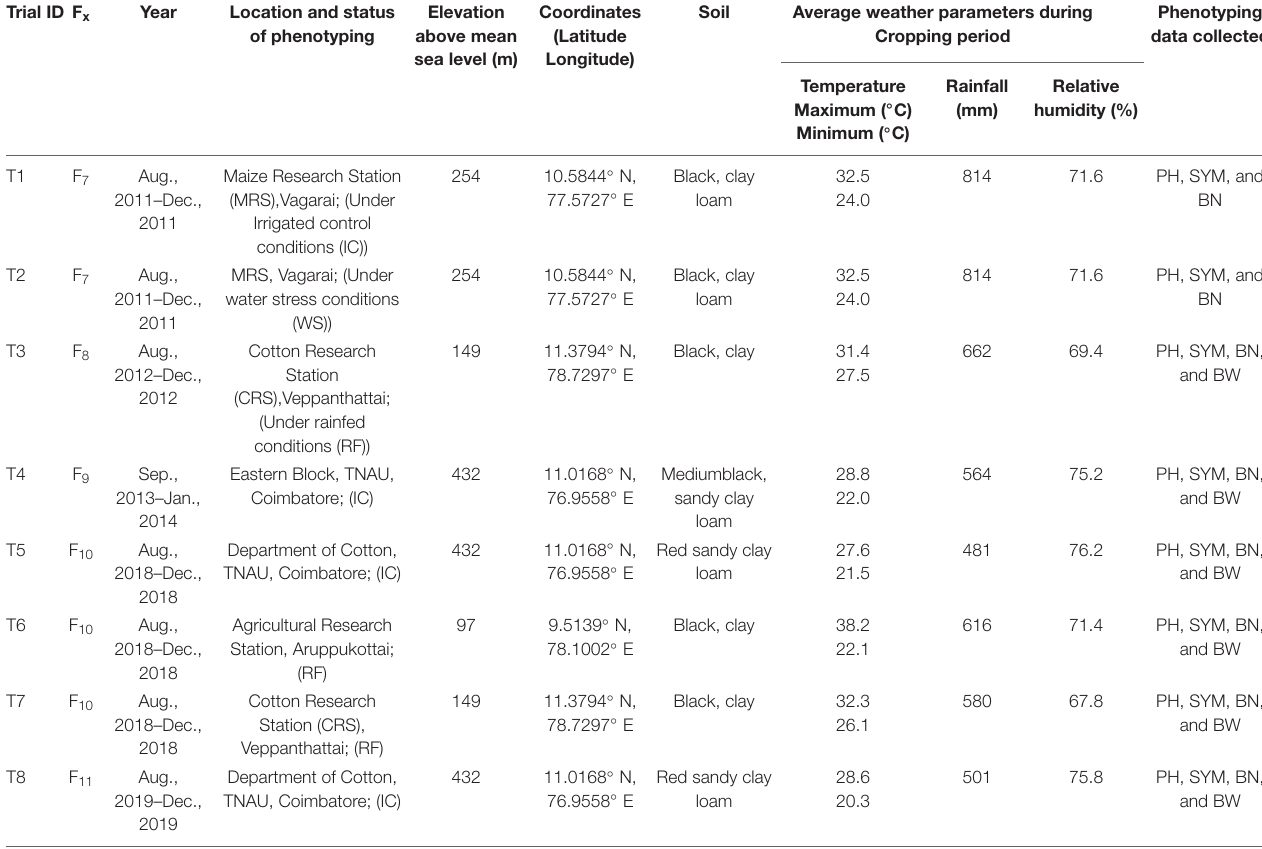
TABLE 1 | Details on testing environments used for the phenotyping of different recombinant inbred line (RIL) generations derived from MCU5 and TCH1218. Trial ID F